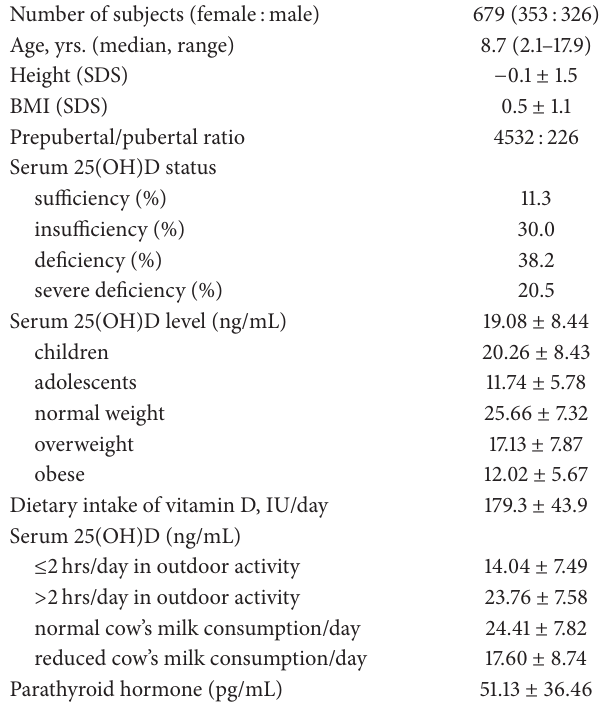
Table 1: Main data of the cross-sectional evaluation of Italian children and